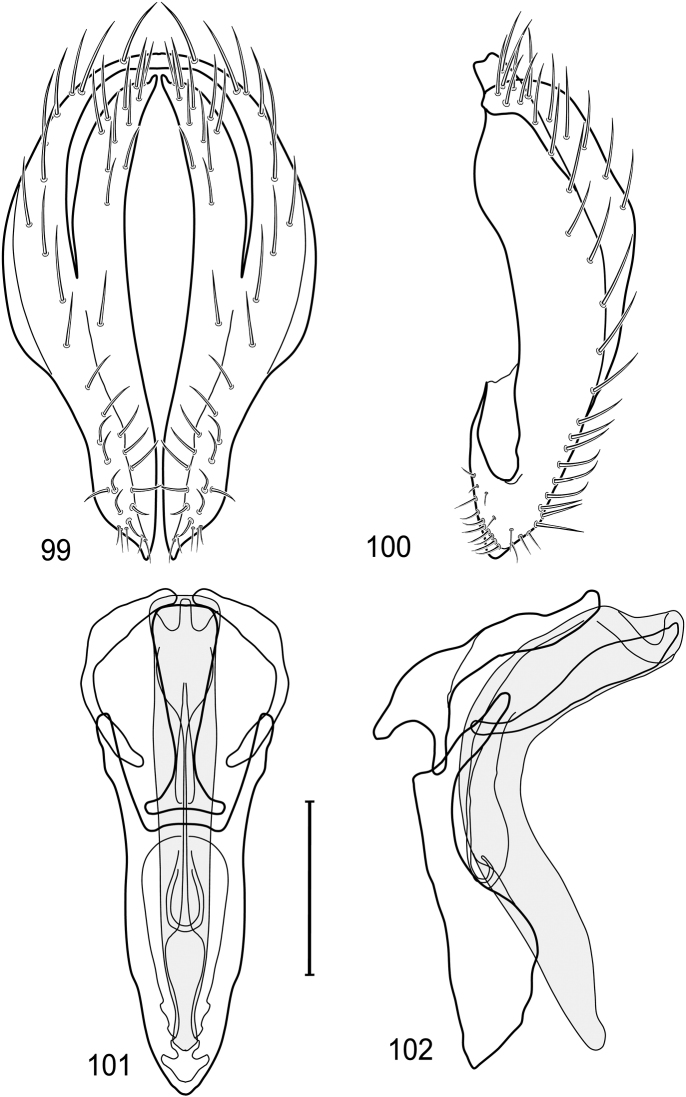
Illustration of Polytrichophora salix sp. n. (male) (Idaho. Kootenai: Fernan Lake) 99 epandrium and cerci, posterior view 100 same, lateral view 101 internal structures of male terminalia (aedeagus [shaded], phallapodeme, gonite, hypandrium), ventral view 102 same, lateral view. Scale bar = 0.1 mm.